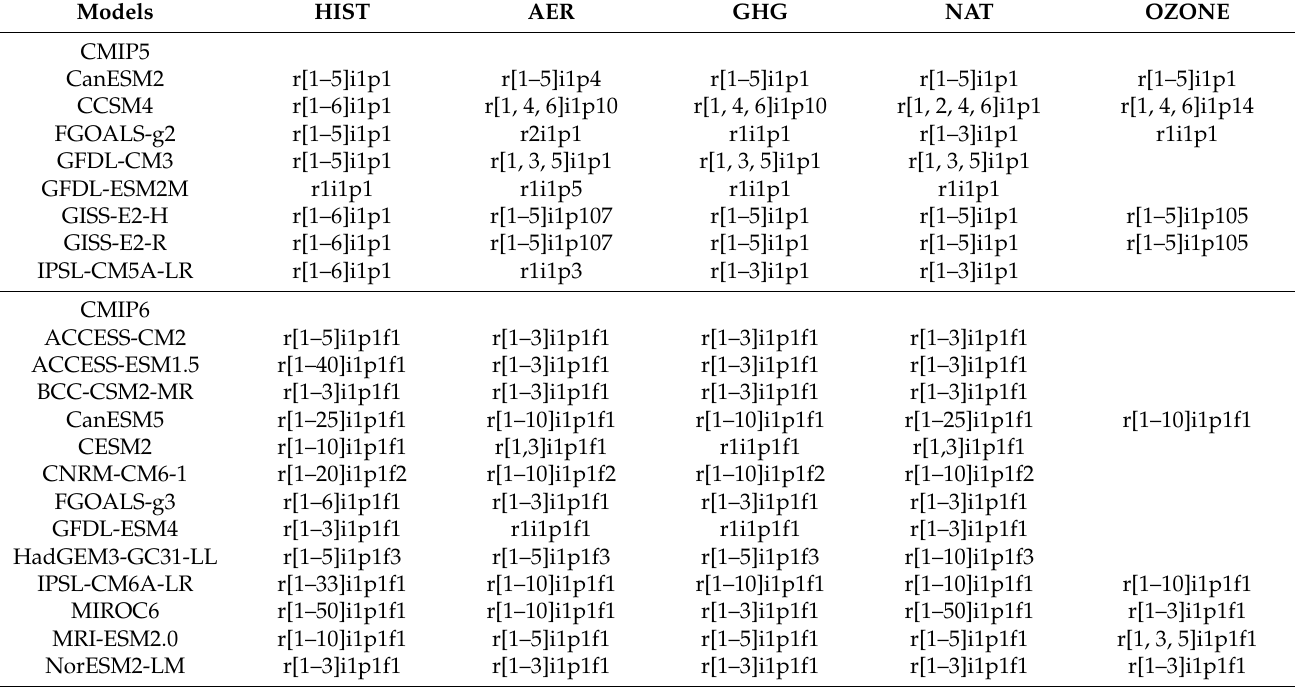
Table 1. The CMIP5 and CMIP6 models, simulations, and ensembles used in the current